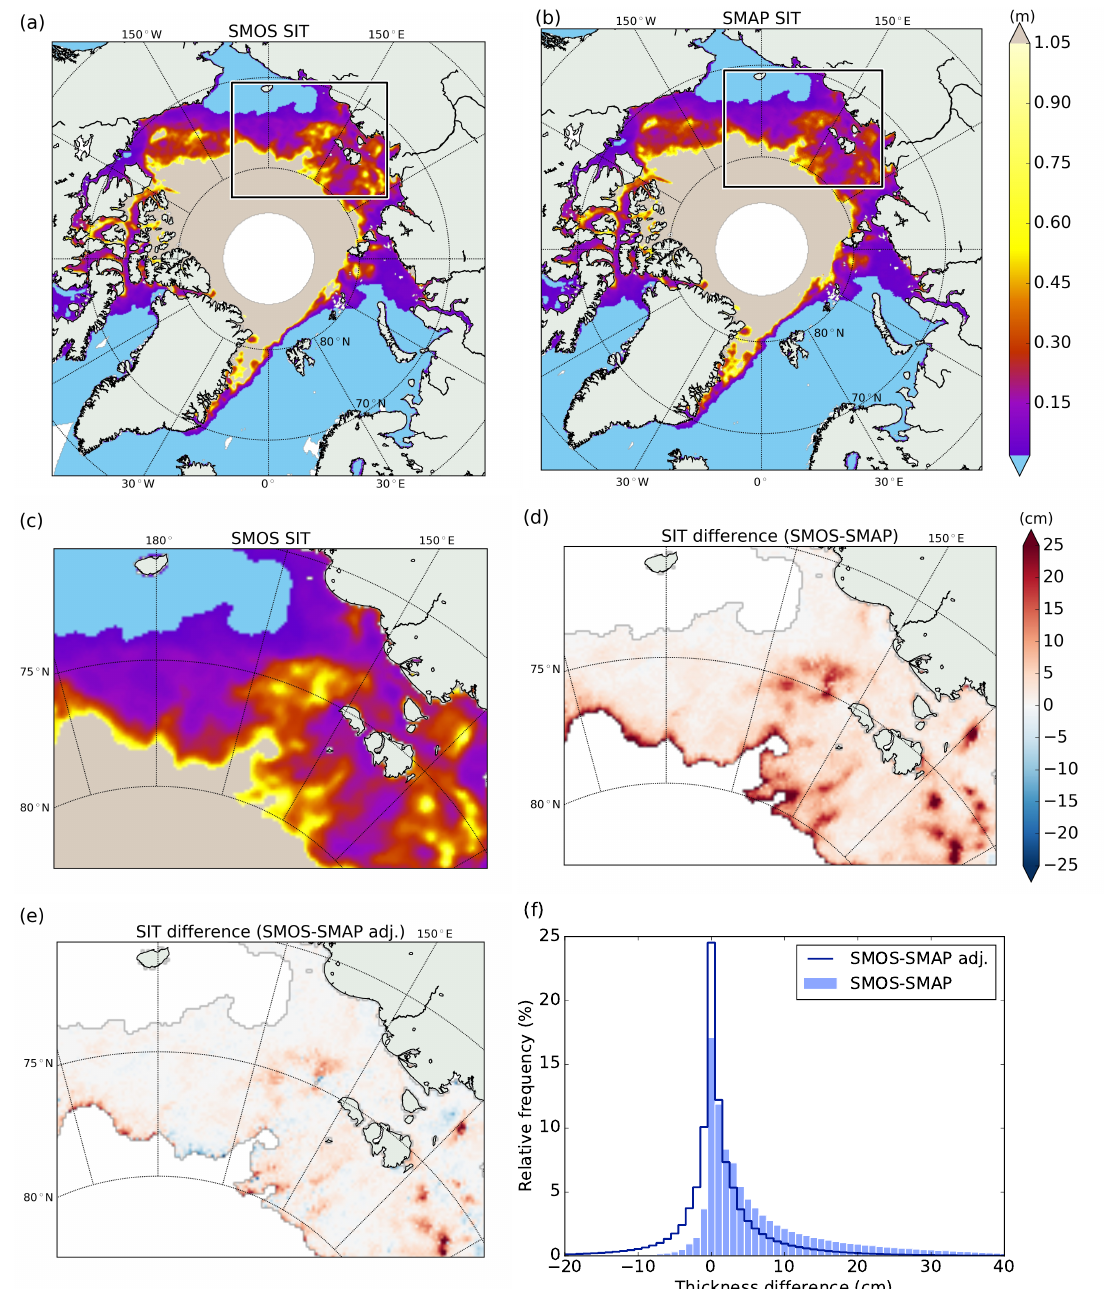
Figure 11. Sea ice thickness (SIT) on 1 November 2015 derived using TBs from SMOS ( a ) and SMAP ( b ); gray areas denote saturation of the signal. The rectangle marks the zoom area of SMOS SIT ( c ); as well as thickness differences between SMOS and SMAP ( d ) and between SMOS and SMAP with adjusted TB bias ( e ); ( f ) histogram of ice thickness differences for all thicknesses between 2cm and saturation during the considered winter season (15 October 2015–15 April 2016) in the